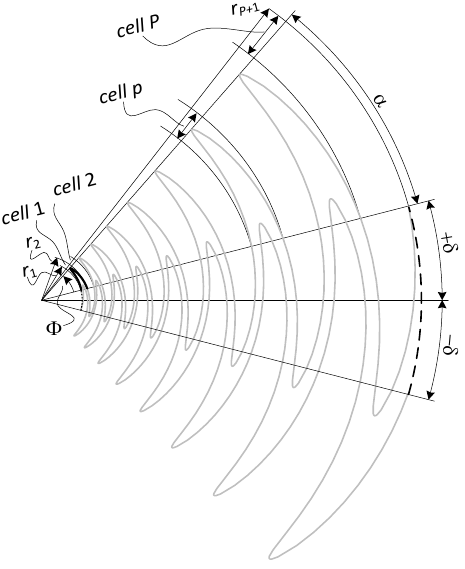
Figure 1. An arm of the antenna and its geometry.